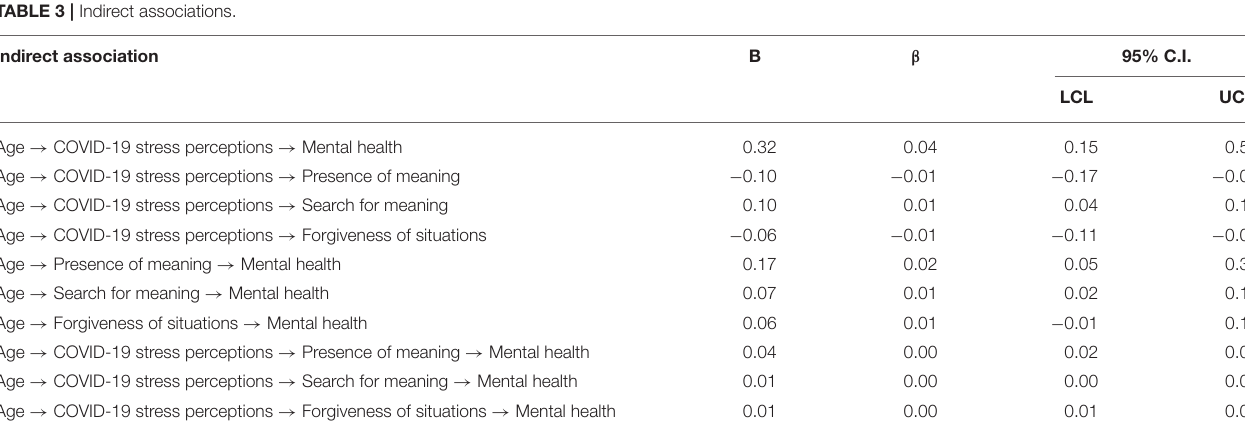
TABLE 3 | Indirect